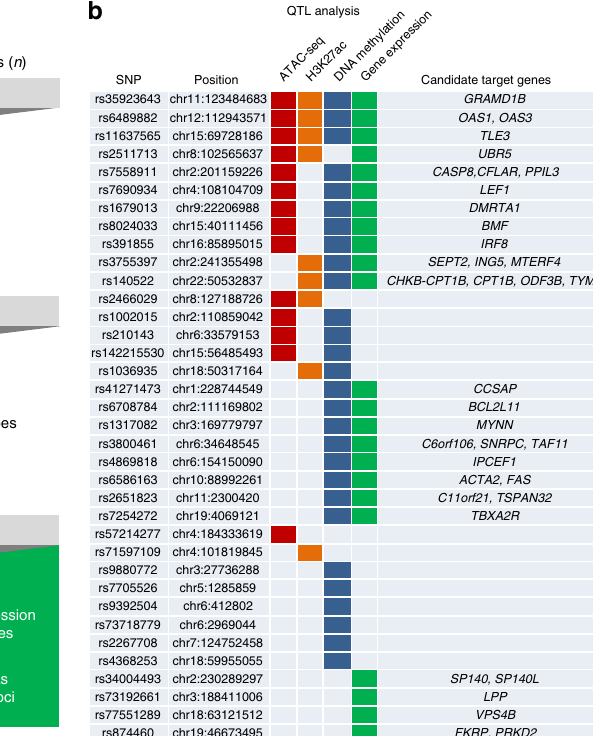
rs373038216) were absent in the 1000 Genomes data and therefore excluded (LD regions could not be calculated). One BC risk locus (rs8176636) could not be mapped to the GRCh38 genome build and was therefore excluded. Three CRC risk loci were excluded (rs7758229, rs6061231, rs11064437) as they have only been reported in Asian populations.